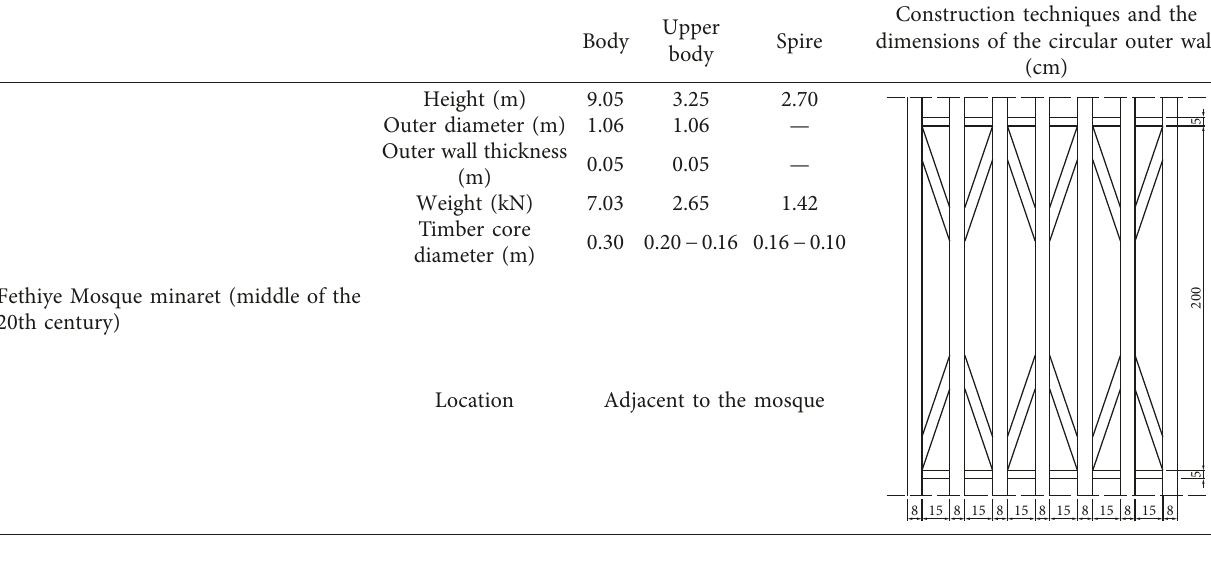
Table 3: The geometric properties and construction techniques of the Fethiye Mosque minaret.